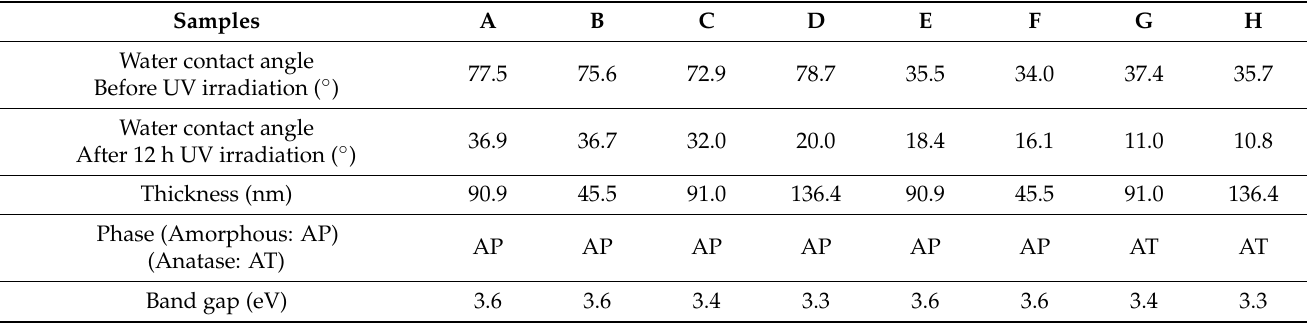
Table 3. The summaries of the analytical data of all samples.